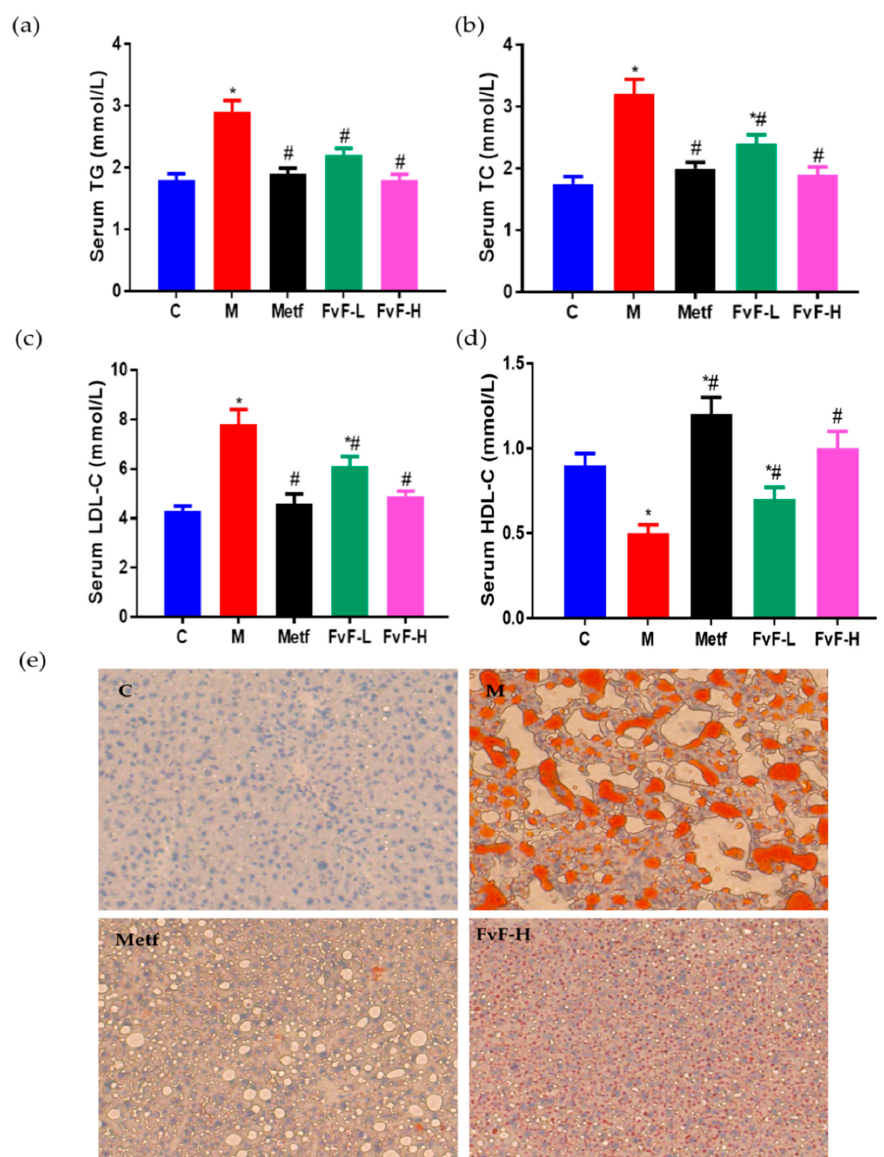
Figure 5. Effects of fucoidan from Fucus vesiculosus (FvF) on the serum and liver lipid profile in high-fat diet (HFD) and streptozotocin (STZ)-induced metabolic syndrome (MetS) mice. ( a ) Serum triacylglycerol (TG); ( b ) Serum total cholesterol (TC); ( c ) Serum low density lipoprotein-C (LDL-C); ( d ) Serum high density lipoprotein-C (HDL-C); ( e ) lipid accumulation in liver tissue characterized by Oil Red O staining (100×). C, mice were fed a normal diet; M, mice were fed a HFD; Metf, mice were fed a HFD with 225 mg/kg/day metformin; FvF-L, mice were fed a HFD with 20 mg/kg/day FvF; FvF-H, mice were fed a HFD with 100 mg/kg/day FvF. Data are expressed as the mean ± SEM. Differences were assessed by ANOVAs and statistical results are denoted as follows: * p < 0.05 versus the control group; # p < 0.05 versus the model group.